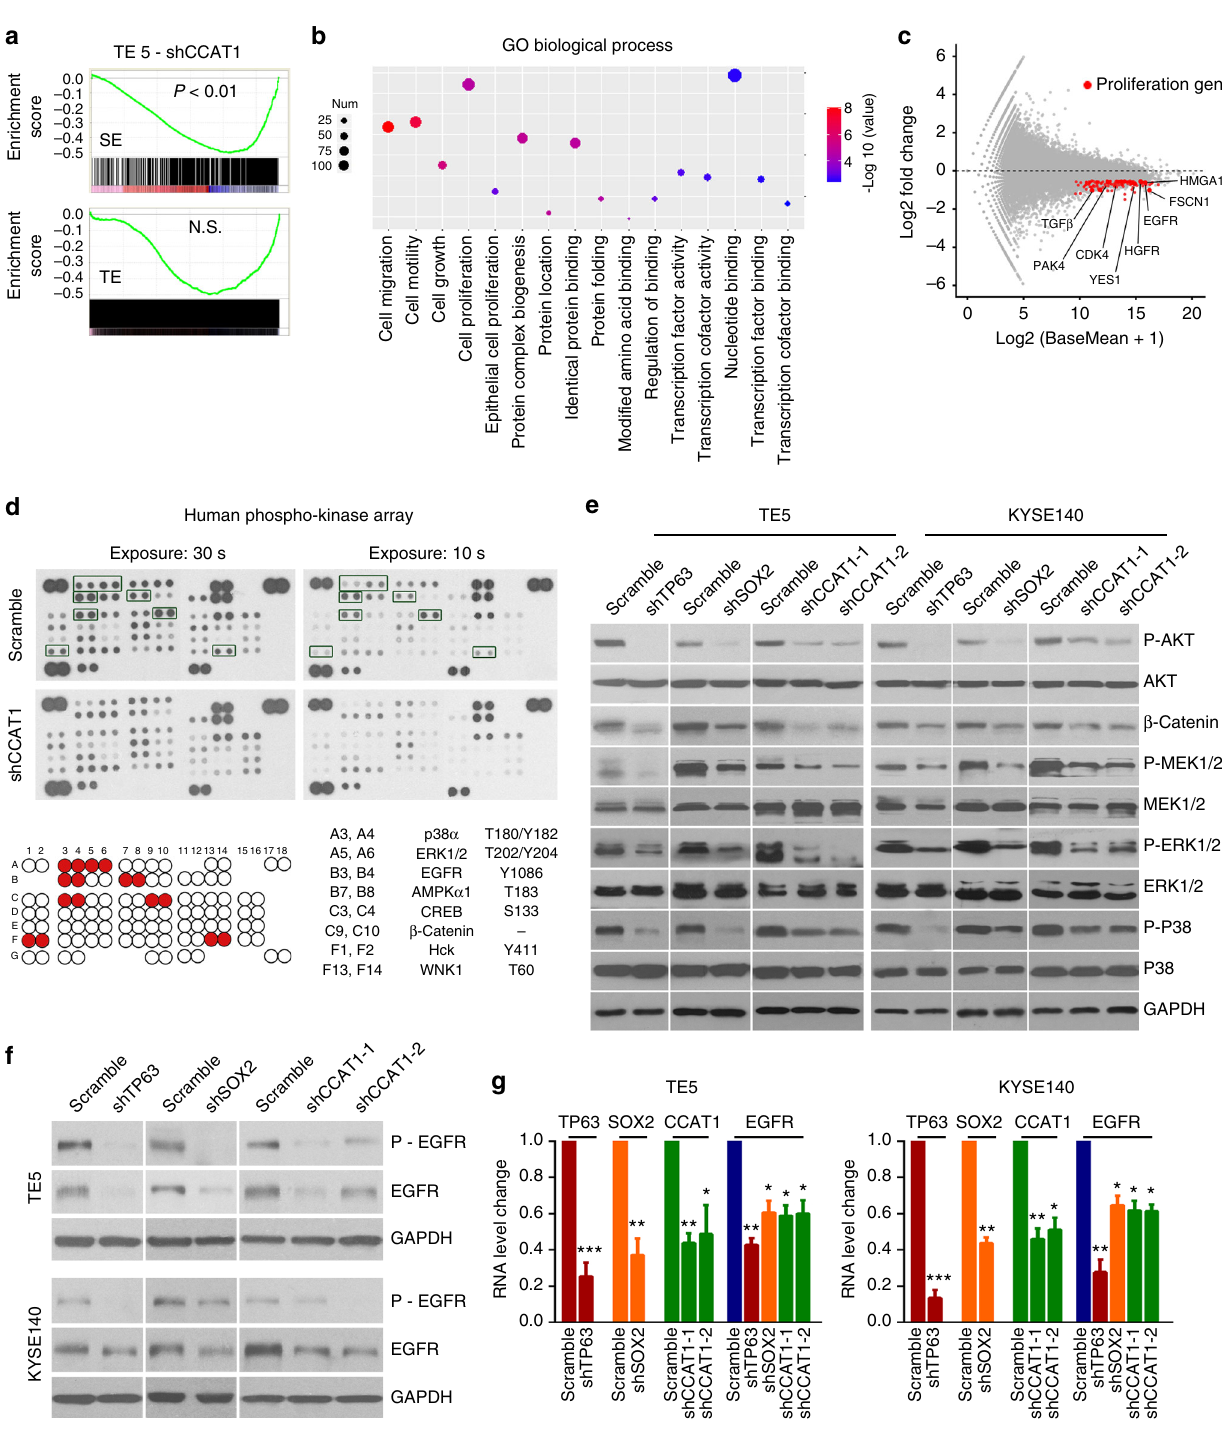
Fig. 5 CCAT1 regulates MEK/ERK1/2 and PI3K/AKT signaling pathways. a Gene set enrichment analysis (GSEA) of fold changes of either super-enhancer (SE)-or typical-enhancer (TE)-associated transcripts following CCAT1 silencing. b GO enrichment analysis of downregulated genes upon CCAT1 knockdown. Color of circles denotes fold changes and dot size represents the number (num) of genes enriched. c MA plot analysis of RNA-seq showing differentially expressed genes upon CCAT1 silencing. Red dots are representative downregulated proliferation genes. d Human phospho-kinase array detects phosphorylated proteins in scramble and CCAT1-silenced TE5 cells. Red dots represent phosphorylated proteins showing alterations, and these proteins and their phosphorylation sites were shown on bottom right. e Western blotting analysis of the proteins highlighted in d and mediators of MEK/ ERK1/2 and PI3K/AKT signaling pathways in TE5 and KYSE140 SCC cell lines following TP63, SOX2, or CCAT1 silencing. f Western blotting detection of phosphorylated EGFR (p-EGFR) and total EGFR in two SCC cell lines upon silencing of TP63, SOX2, or CCAT1. g Relative mRNA expression of EGFR upon knockdown of TP63, SOX2, or CCAT1 in TE5 and KYSE140